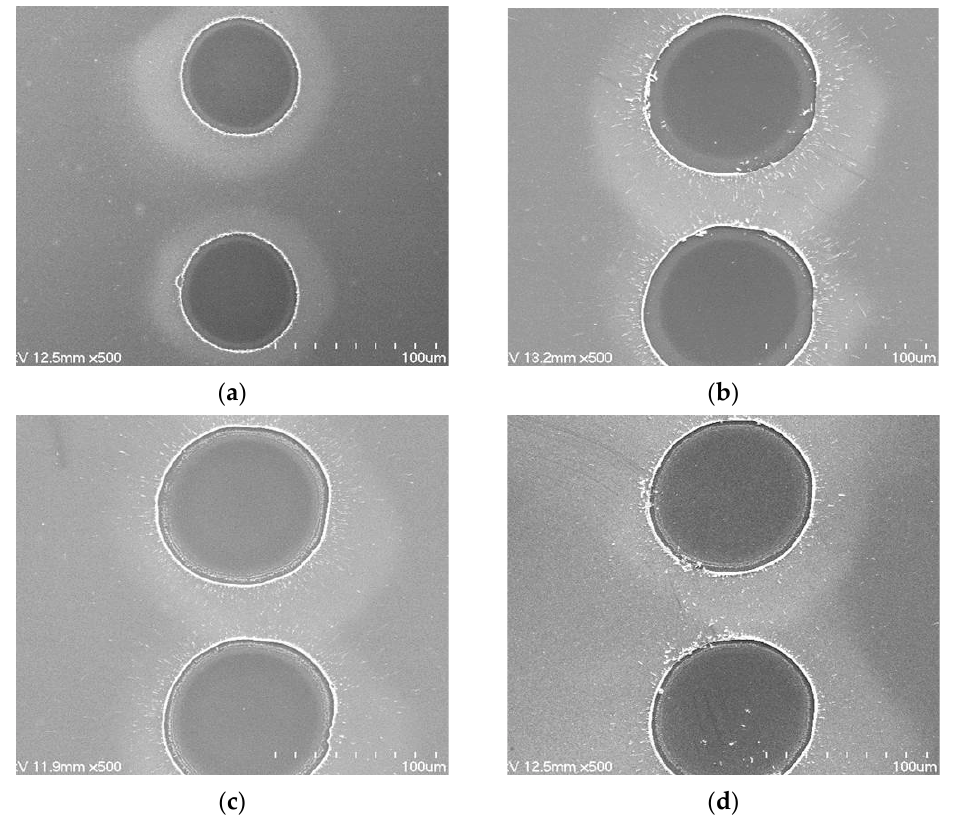
Figure 5. SEM images of laser-ablated ITO/Ag/ITO MLs with different Ag thicknesses of ( a ) 0, ( b ) 6, ( c ) 13, and ( d ) 16 nm at scanning speed of 2000 mm/s and laser pulse energy of 97 μ J.